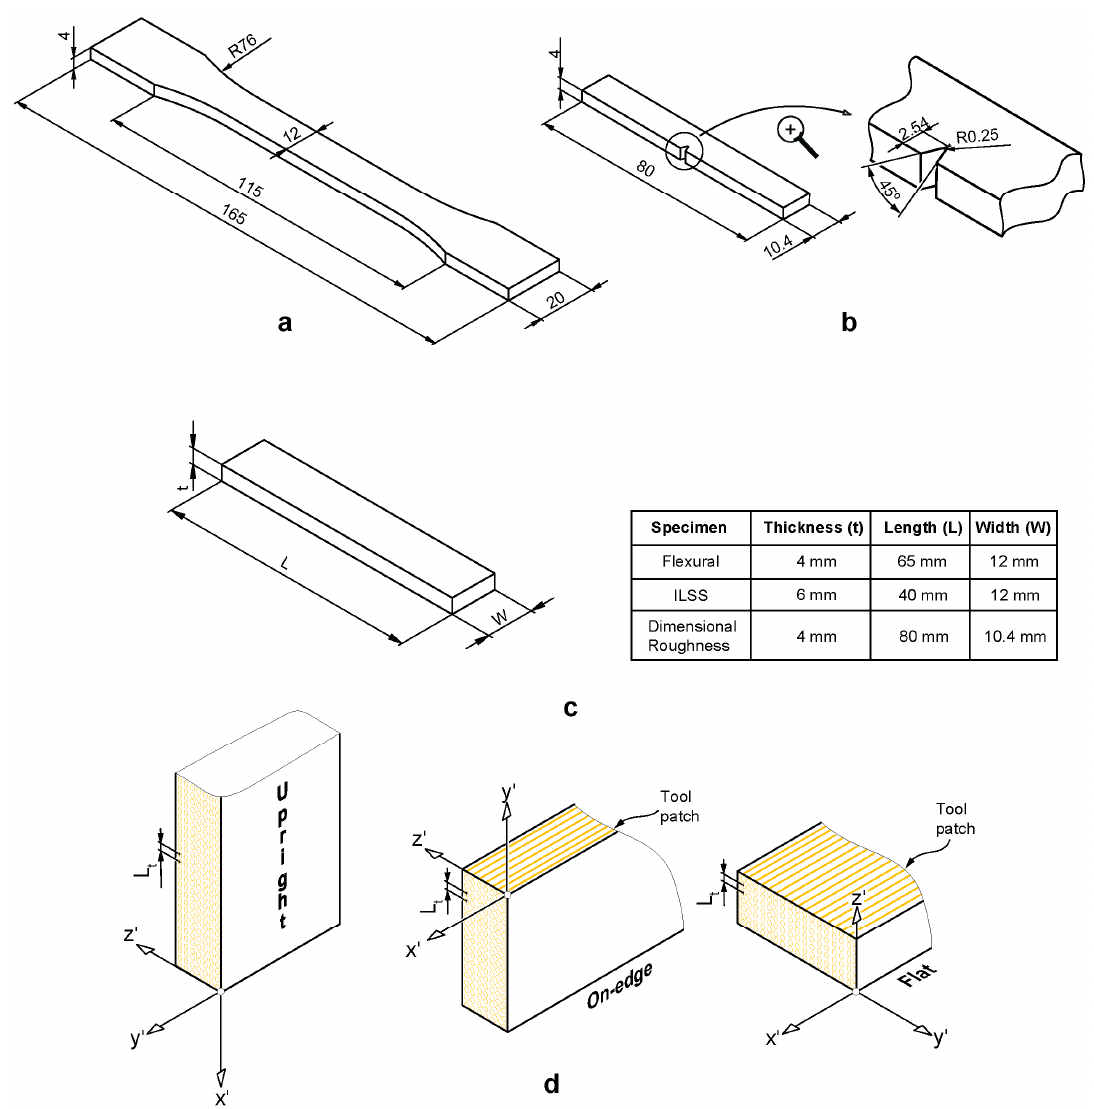
Figure 3. Standard specimens for mechanical testing. ( a ) Tensile specimen; ( b ) Charpy impact specimen; ( c ) Flexural, interlaminar shear strength (ILSS) and dimensional specimens; ( d ) Details of layer thickness (L t ) and build orientations (Upright, On-edge and Flat) used in this study. Dimension are in mm.